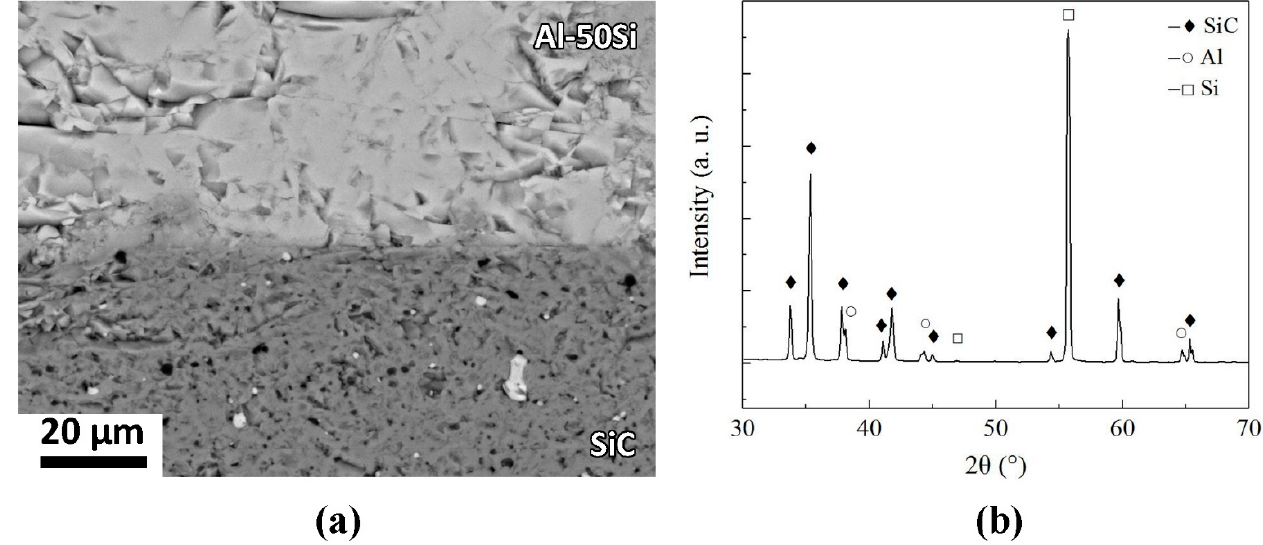
Figure 6. ( a ) Backscattered electron micrograph of Al-50Si/SiC joint showing no obvious interfacial reaction layer or microcracks; ( b ) XRD pattern of Al-50Si/SiC joint.